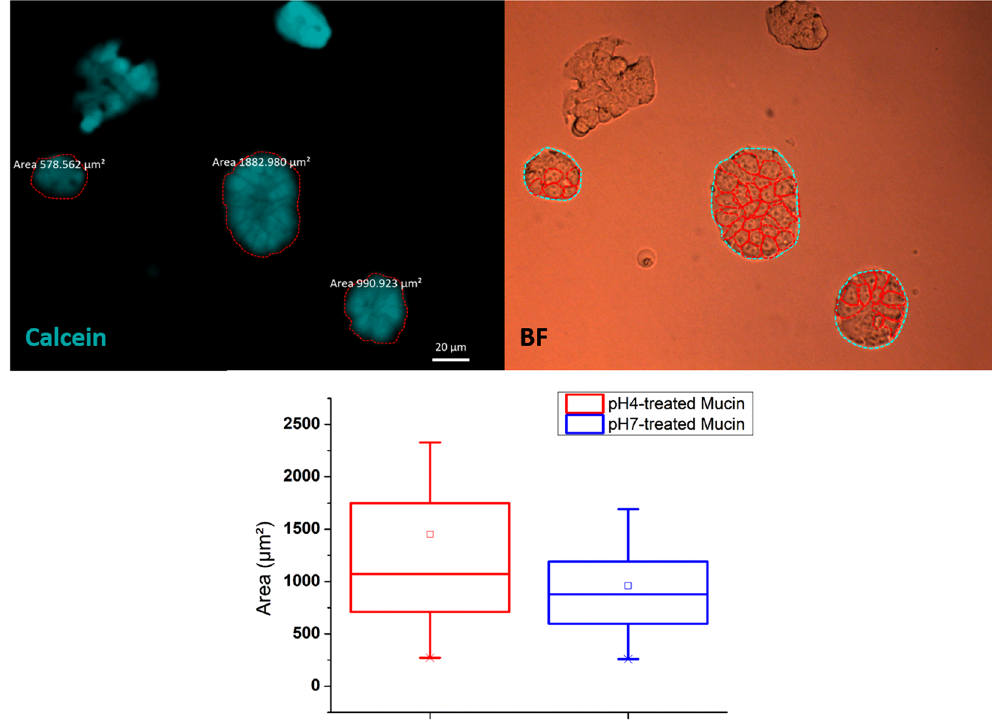
Figure 5. Fluorescence and brightfield optical micrographs of HT-29-MTX cells on mucin samples after 72 h. Red lines in bright field micrographs highlight the boundaries in between individual cells. Scale bar indicates 20 µ m. Boxplot below shows the distribution of the area occupied by the cell aggregates on pH 4 (red) or pH 7 (blue) treated films. The square ( □ ) in the box plot represents the mean value, the box-splitting horizontal line gives the median, and the upper and lower value are indicative of the achievement of either the 99% or 1% of the population,